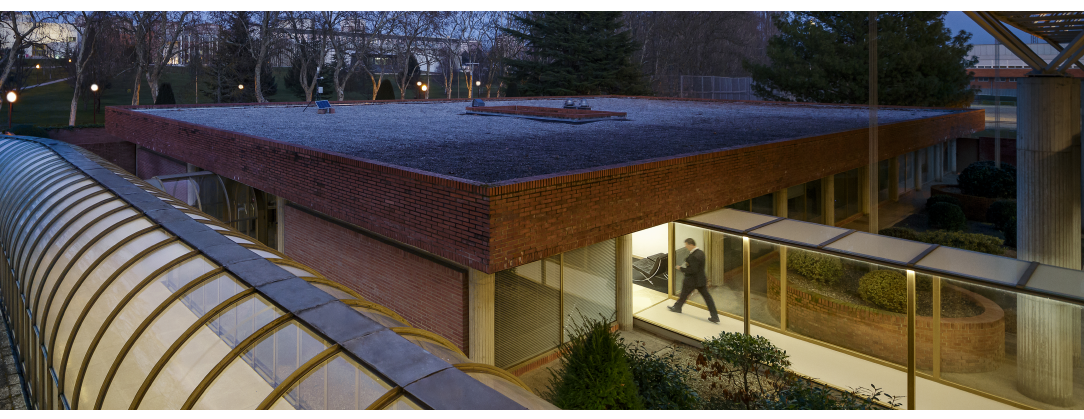
Figure 1. The Architecture School administrative building of the University of